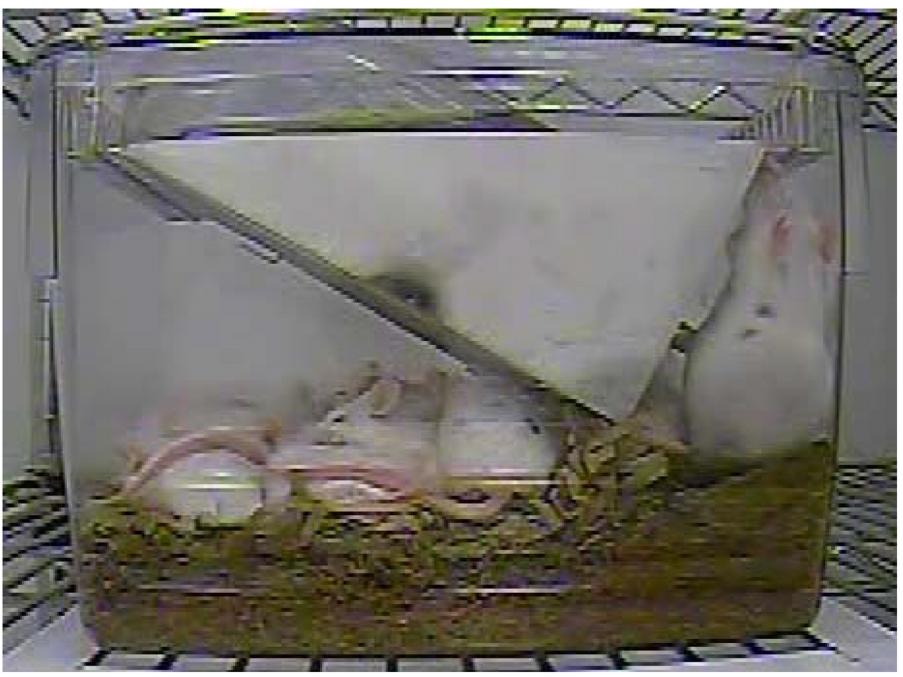
Fig 2. Image illustrating “ press posture ” . This behavior is characterized by the placement of the ventral surface of the body in the corner of the cage and a subsequent lack of movement. Mice were often observed to fall asleep in this